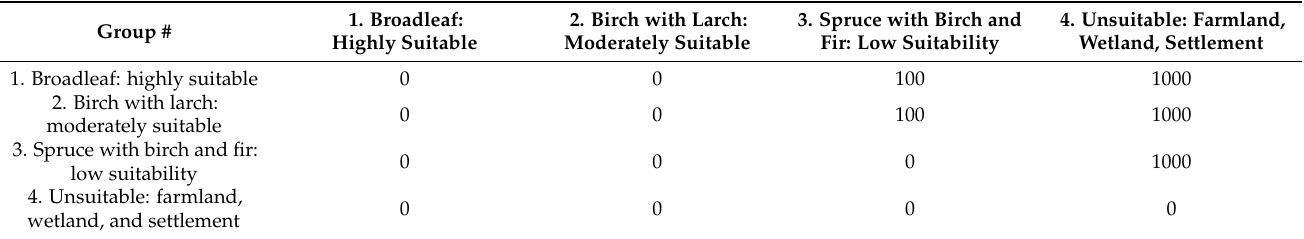
Table A2. Edge depth matrix between groups of habitats used for calculation of core area index (meters).